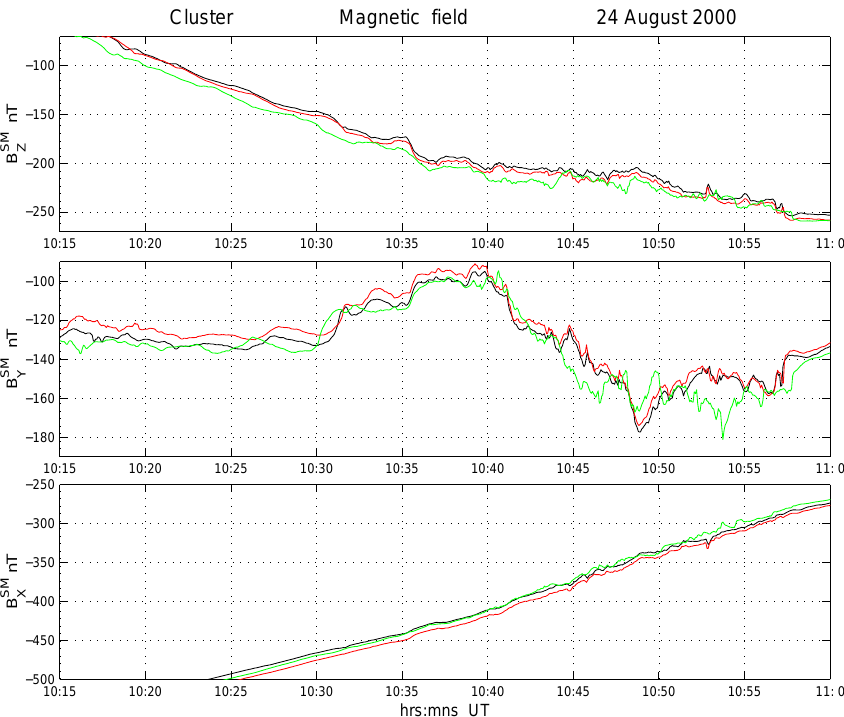
Fig. 6. The Y , Z and X magnetic field components in SM coordinates between 10:15 and 11:00UT on 24 August 2000. This corresponds to the region of field-aligned currents in the northern cusp.